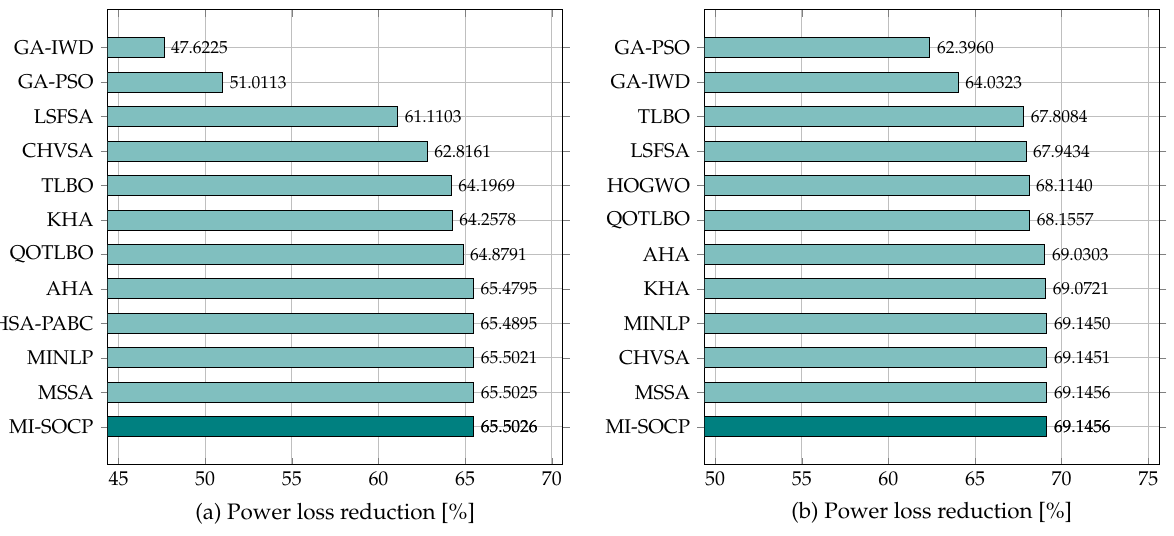
Figure 4. Power loss reduction for Case-1: ( a ) IEEE 33-bus system and ( b ) IEEE 69-bus system.